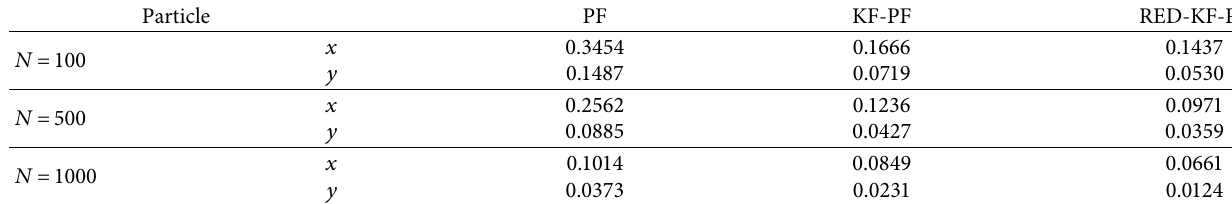
Table 1: Comparison of RMSE.